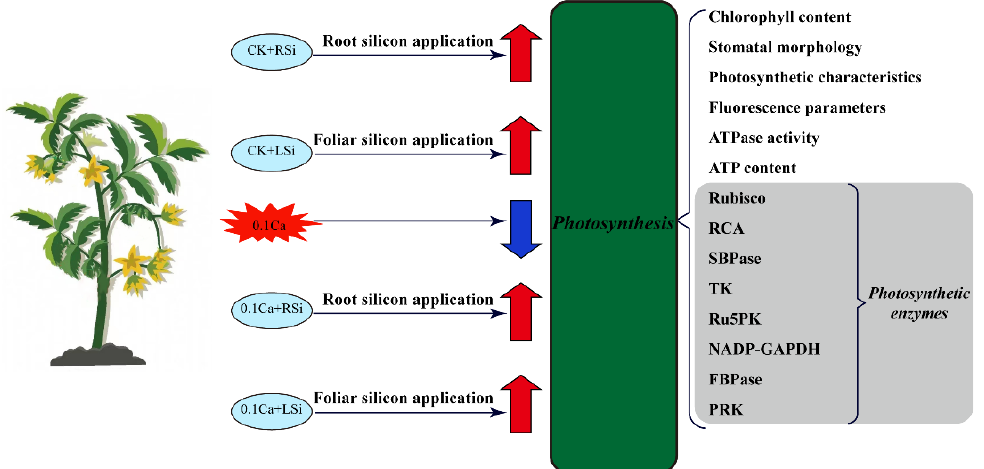
Figure 9. Simplified schematic diagram of photosynthetic response of tomato seedlings to 0.1Ca, 0.1Ca + RSi, and 0.1Ca + LSi. Negative regulation is indicated by the blue down arrow, Positive regulation is indicated by the red up arrow. CK + RSi: 4 mM Ca in Hoagland nutrient solution + root application of 1 mM Si; CK + LSi: 4 mM Ca in Hoagland nutrient solution + foliar application of 1 mM Si; 0.1Ca: 0.1 mM Ca in Hoagland nutrient solution; 0.1Ca + RSi: 0.1 mM Ca in Hoagland nutrient solution + root application of 1 mM Si; 0.1Ca + LSi: 0.1 mM Ca in Hoagland nutrient solution + foliar application of 1 mM Si. RuBPCase: ribulose 1,5 − bisphosphate carboxyhase; RCA: rubisco activation enzyme; SBPase: 1,7 − diphosphoric acid cingulum heptulosylase; TK: transketolase; Ru5PK: Ribulose 5 − phosphate kinase; NADP − GAPDH, glyceraldehyde − 3 − phosphate dehydrogenase; FBPase: Fructose − 1,6 − bisphosphatase; PRK: Ribulose − 5 − phosphate kinase.